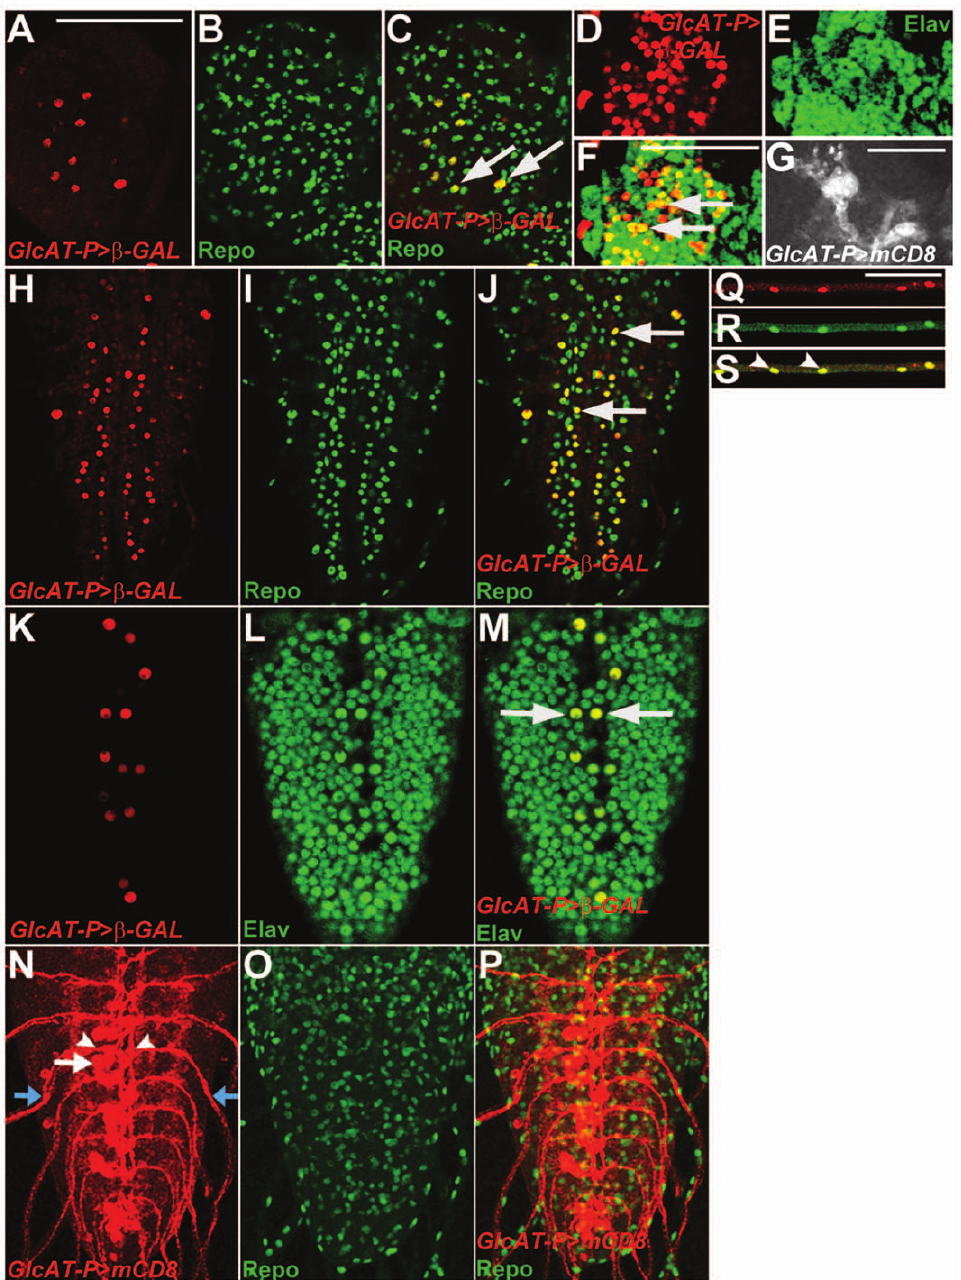
Figure 2. Analysis of GlcAT-P expression as revealed by GlcAT-P-GAL4 driven reporter. GlcAT-P is expressed in the larval brain lobes (A–G), the VNC (H–P) and peripheral nerves (Q–S) in the L3 larva brain. lacZ reporter expression in the brain lobes (red, A) colabeled with a -Repo (green, B). (C) Merged frames showing that GlcAT-P is expressed in a subset of Repo-positive glial cells (yellow; arrows). lacZ reporter expression in the mushroom bodies (red, D) colabeled with the neuronal marker Elav (green, E). Merged frame (F) showing co-staining of GlcAT-P and Elav in Kenyon cells (yellow; arrows). (G) Membrane targeted reporter ( UAS-mCD8-mCherry ) reveals expression of GlcAT-P in Kenyon cell neurites. lacZ reporter expression (H, K) in the larval VNC double labeled with a -Repo (I, J) or a -Elav (L, M). GlcAT-P is expressed in a subset of glial cells (yellow, arrows in J). GlcAT-P expression is also found in about two Elav positive neurons in ventral midline positions (yellow, arrows in M). (N–P) UAS-mCD8-mCherry reporter expression reveals that two cells (white arrow in N) bifurcate (arrowheads) and extend motor axons (blue arrows) bilaterally into the periphery. (P). GlcAT-P . lacZ reporter expression (Q) in cells on peripheral nerves are shown. These cells are peripheral glia as they colabel with Repo (R; yellow and arrows in S). A–F, H–J and K–M show individual frames of 1 m m thickness. G and N are maximum projections of Z-stacks. Bars in A, S: 50 m m. Bars in F, G: 10 m m.